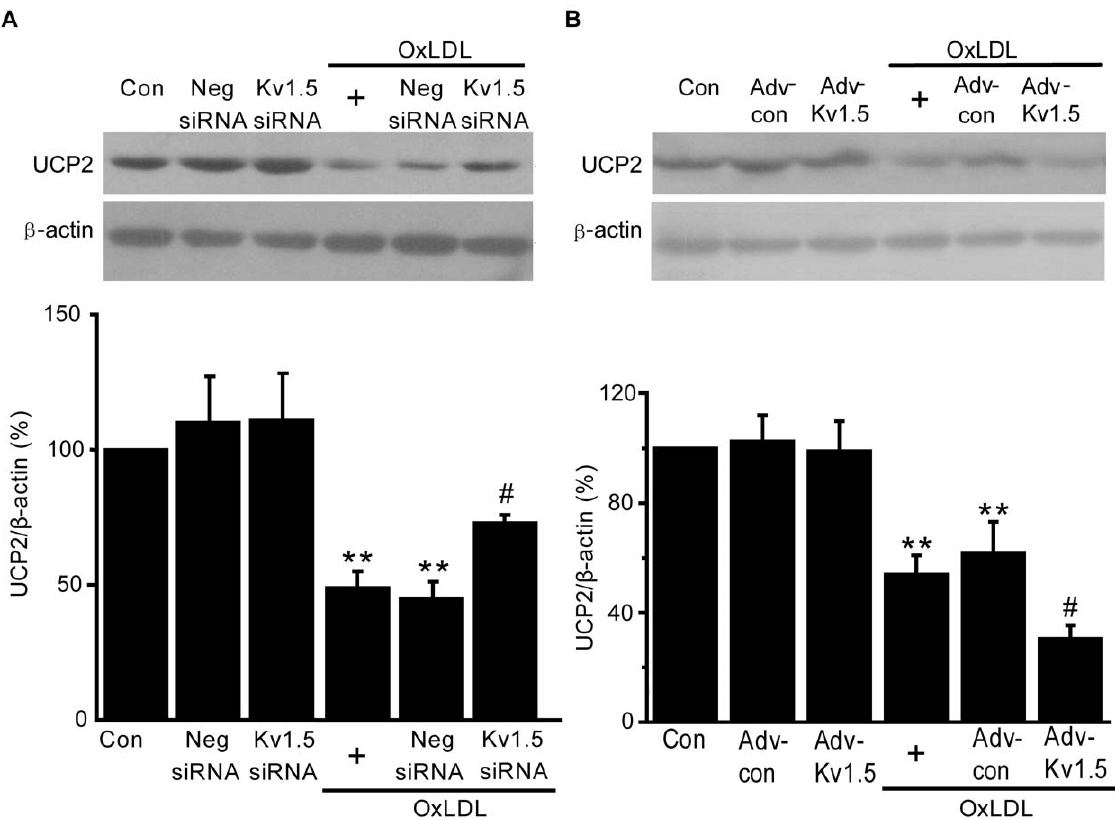
Figure 7. OxLDL-induced reduction in UCP2 protein was restored by Kv1.5 siRNA, but exaggerated by Kv1.5 overexpression. The UCP2 protein expression was detected by western blot in HPAECs transfected with Kv1.5-siRNA (A) and or infected with adnovirus containing KCNA5 (B). Digital photographs showing UCP2 protein expression are on the top panel and bar graph showing quantitative analysis of the total protein are on the lower panel. The values are presented as means 6 SEM of 6 independent experiments. ** P , 0.01 vs. corresponding control group; # P , 0.01 vs. oxLDL group.